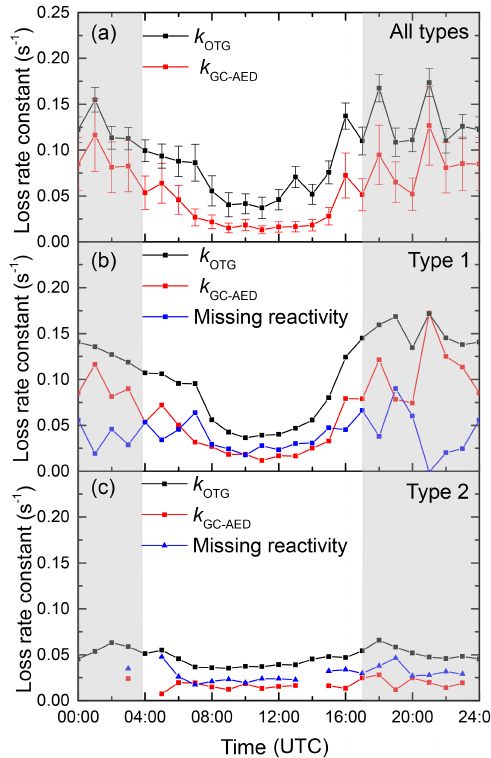
Figure 9. (a) Campaign averaged diel cycle of NO 3 reactivity ( k OTG ) and the reactivity calculated from the monoterpenes re- ported by the GC-AED. The error bars represent the overall uncer- tainty in each parameter and not variability. Panels (b) and (c) show data from type 1 nights (significant nocturnal temperature inversion) and type 2 nights (weak or no nocturnal temperature inversion) re-